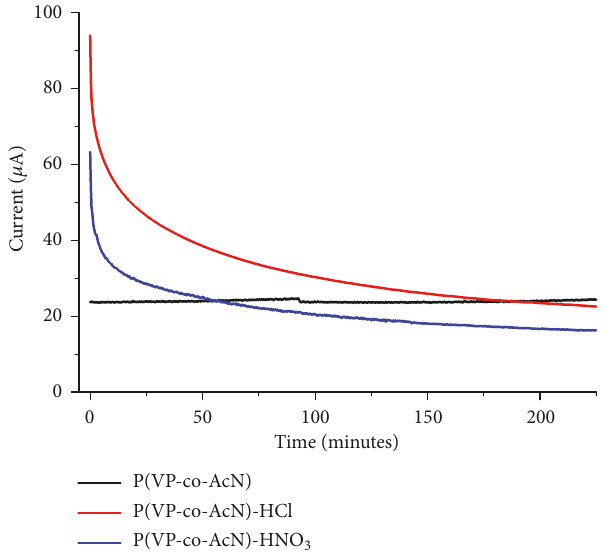
Figure 17: Time v/s current plots for the copolymer and the respective